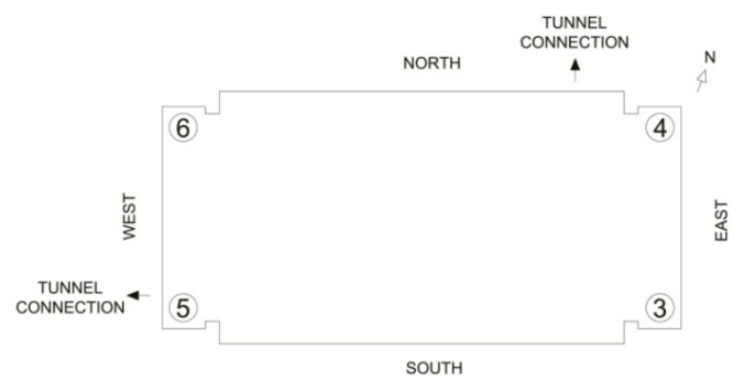
Sensors 2016 , 16 , 1016 10 of 23 during ambient vibrations and the 5/14/2011 event. The torsional frequencies (1.47 and 5.05 Hz) are associated with the largest jumps in power content of the recorded motions. Figure 11 (right), shows the majority of spectral power at floor 19 to be in the fundamental torsional mode. ( a ) ( b ) ( c ) Figure 11. Cumulative spectral power at floor 12 during 22 June ambient vibrations ( a ) and the 14 May event ( b ) and cumulative spectral power at floor 19 during the 14 May event ( c ). 2.4. Foundation Rocking Motion Base rocking behavior is determined by examining the frequency spectra, coherences, and phase angles of the vertically aligned accelerometers located in the basement level of the Green Building (Figure 12). Base rocking is a form of soil-structure interaction, where the foundation of a building undergoes a rigid-body rotation (Figure 13). The behavior of the vertical accelerometers is investigated around the lower natural frequencies, since differential base motion is expected to be coupled with the building’s torsional and translational modes. The Fourier spectra of the four vertical base accelerometers (Channels 3 to 6) are found in Figure 14. Peaks at 0.74, and 1.48 Hz, (the fundamental EW and torsional modes) are clearly identifiable. This confirms some coupling of base motions with the fundamental translational modes. Figure 15 presents the coherence between the vertical accelerometers in the 0–3 Hz range. Accelerometers located on the same North/South façade